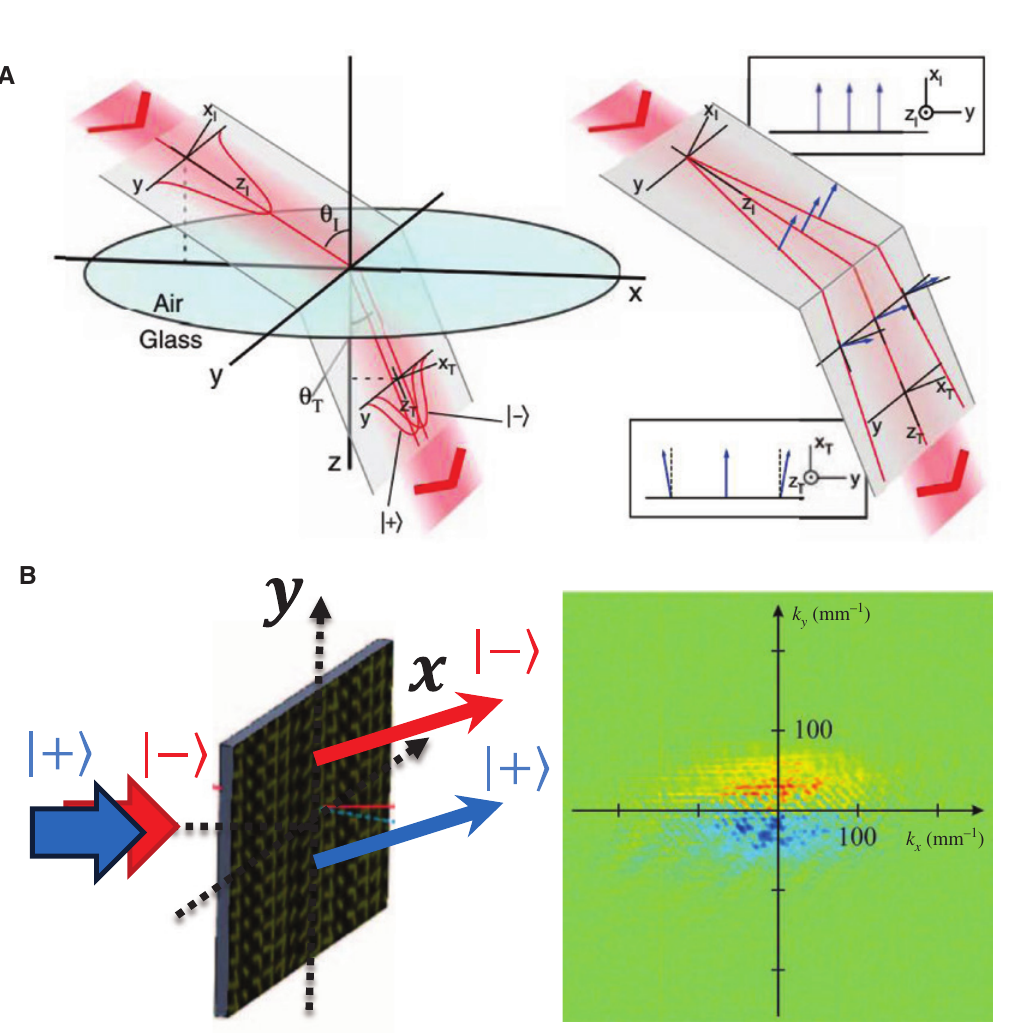
Figure 2: OSHE in giving transverse beam-splitting. (A) Spin-splitting of beam center from air to glass at oblique incidence due to spin-dependent geometric phase picked up by different k -components. Reprinted from Ref. [19]. (B) OSHE at normal incidence using a metasurface, with the beam helicity ( S plotted on the right. Reprinted from Ref.